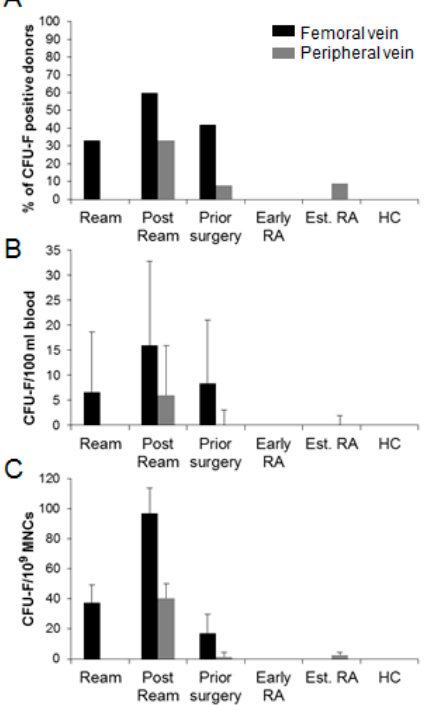
Figure 2. Frequency of MSC from di ff erent donor cohorts. Cohort specific: ( A ) percentage of donors yielding at least one CFU-F; ( B ) CFU-F / 100 ml blood; ( C ) CFU-F / 10 9 MNCs. Error bars are standard deviations.